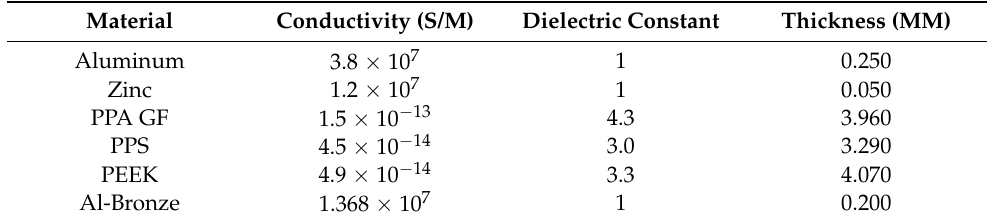
Table 1. The electrical properties of the